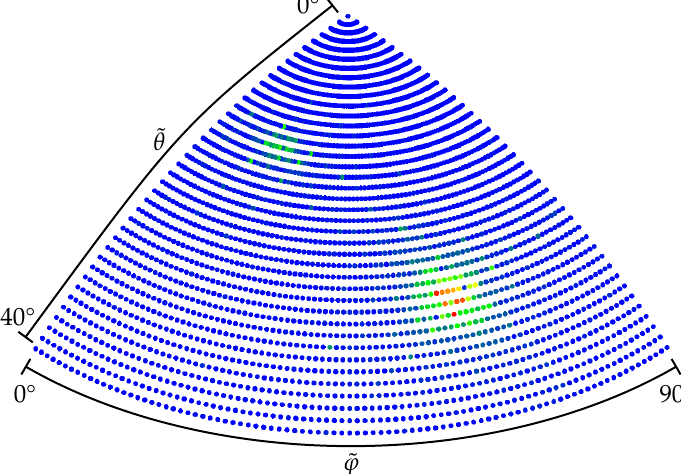
Figure 11. Transformed azimuth/inclination grid of a 1° resolution corresponding to Figure 7. The grid cells contain the summarized weights w i of the contained vertical normal vectors (cid:126) n v angles ( ˜ ϕ i , ˜ θ i ) with value colorization ranging from blue for low values over green and yellow to red for large values. The larger peak corresponds to the floor and the horizontal part of the ceiling, while the minor peak corresponds to one of the slanted ceiling